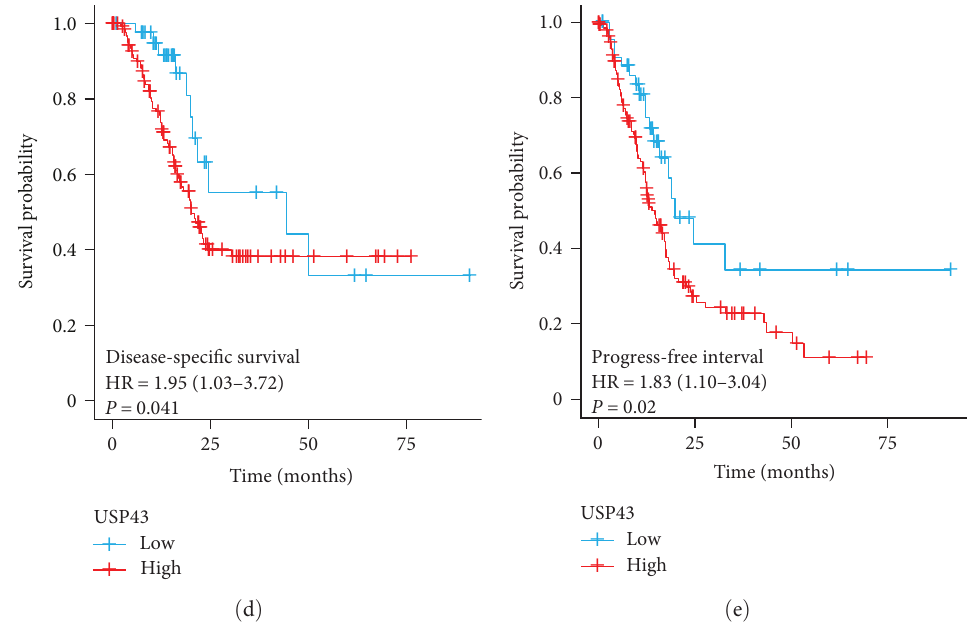
F IGURE 1: USP43 is highly expressed in PAAD and correlate with poor prognosis based on TCGA database: (a) based on TCGA database, we compared 33 kinds of tumor, and the expression of USP43 was signi fi cantly higher in 18 kinds of tumor tissues than normal tissue; (b) based on TCGA database, we analyzed the expression of USP43 in 350 PDAC cases (tumor tissues and normal tissues); (c) according to TCGA databases, we underwent Kaplan – Meier curve to evaluate OS; (d) DSS; and (e) PFI in USP43 high and low group of PDAC patients. ∗∗ P -values < 0.01, ∗∗∗ P -values < 0.001.